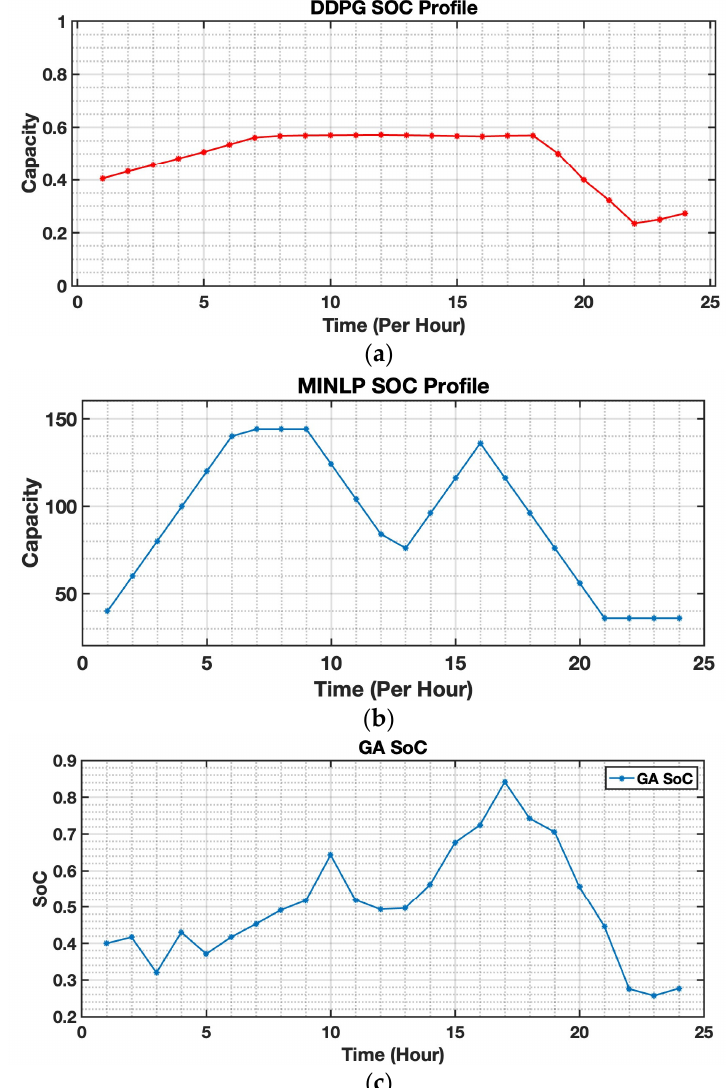
Figure 12. Performance comparison for SOC Profile: ( a ) DDPG; ( b ) MINLP; and ( c ) GA. Table 4. System Constraints.